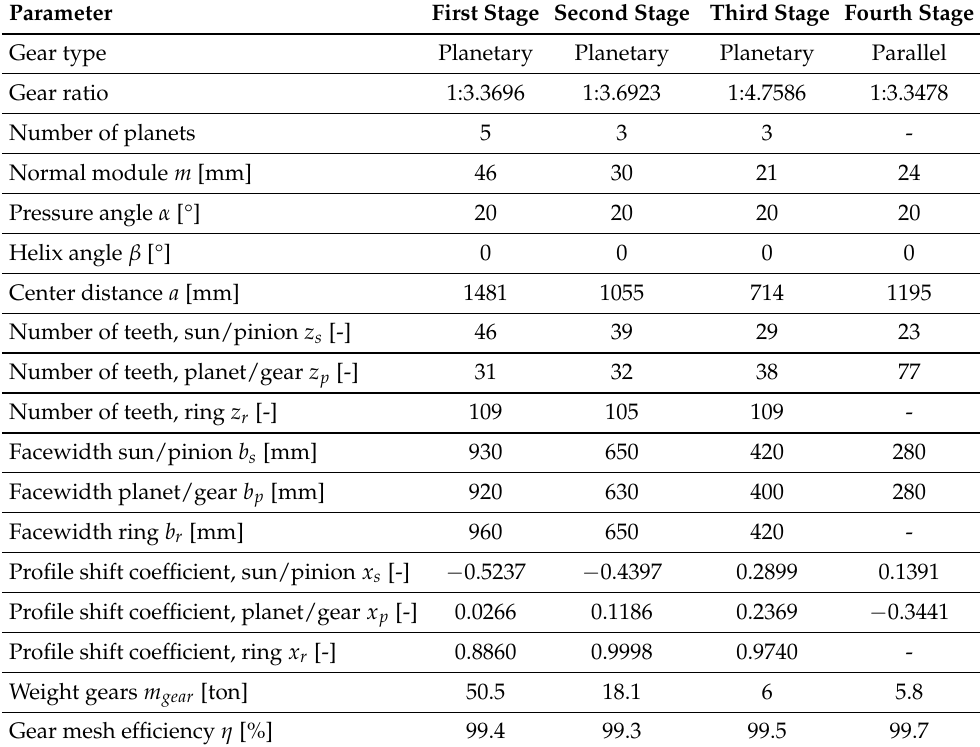
Table 6. Design specification of HS gearbox based on three planetary stages and one parallel stage.